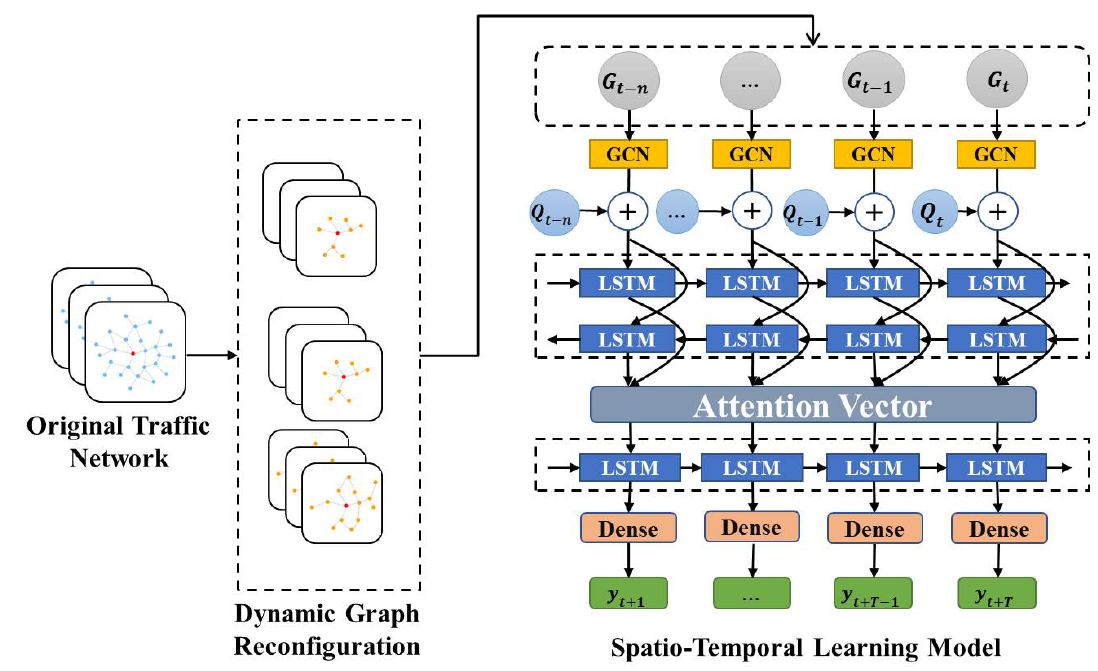
Figure 4. The framework of EnGS-DGR